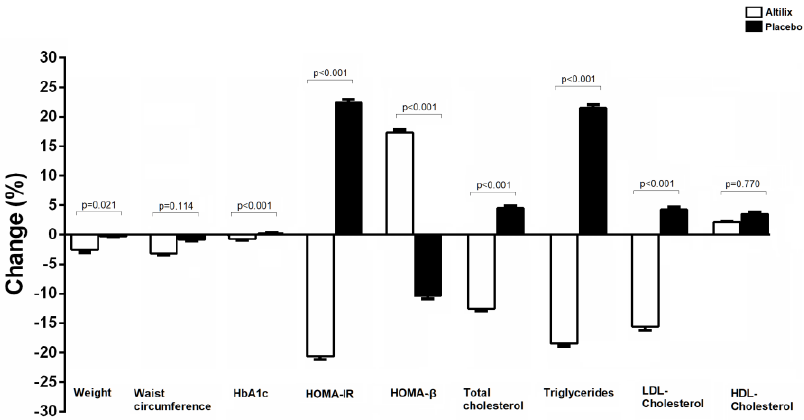
Figure 2. Percentage changes of anthropometric, glycemic and lipid parameters in all subjects.